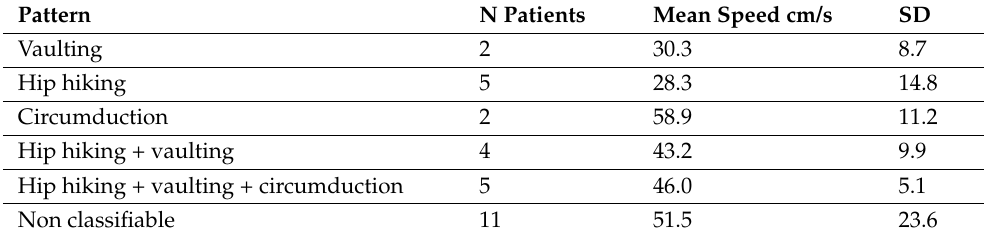
Table 2. Gait pattern.